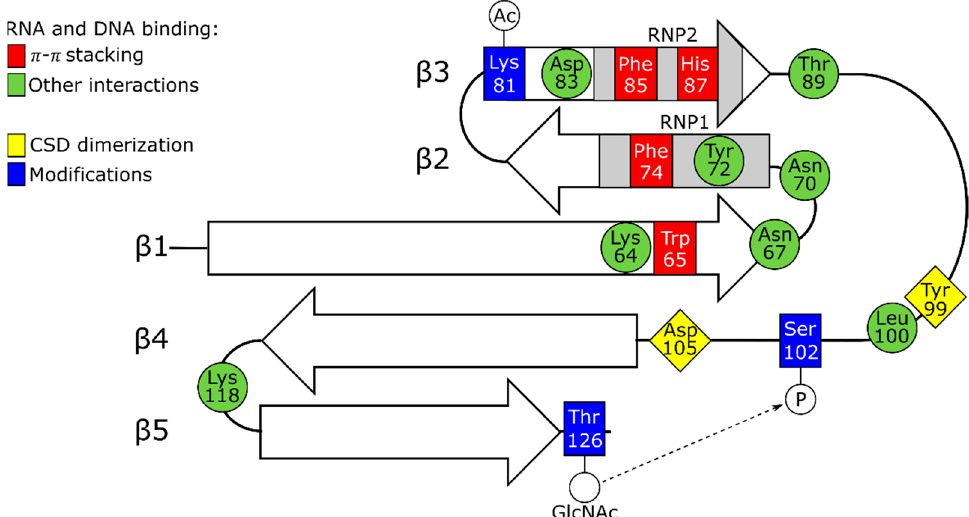
Figure 2. The YB-1 cold shock domain (51–129). Amino acid residues involved in CSD dimerization or nucleic acids binding ( π – π stacking and other interactions) are shown in yellow, red, and green, respectively. The RNP1 and 2 consensuses are gray. Modified amino acid residues are blue. Ac, acetylation; GlNAc, O-GlcNAcylation; P, phosphorylation. The effect of GlNAc-Thr126 on Ser102 phosphorylation is represented.